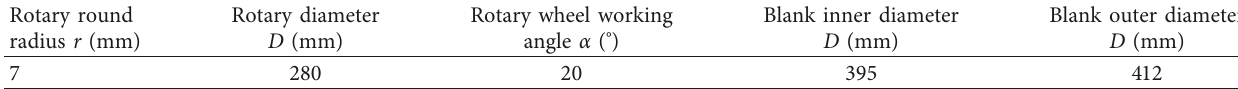
Table 1: Geometric parameters of spinning simulation modeling.